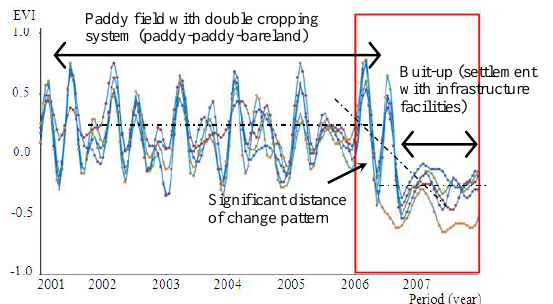
Figure 4. Identification of the change information from a change of temporal EVI